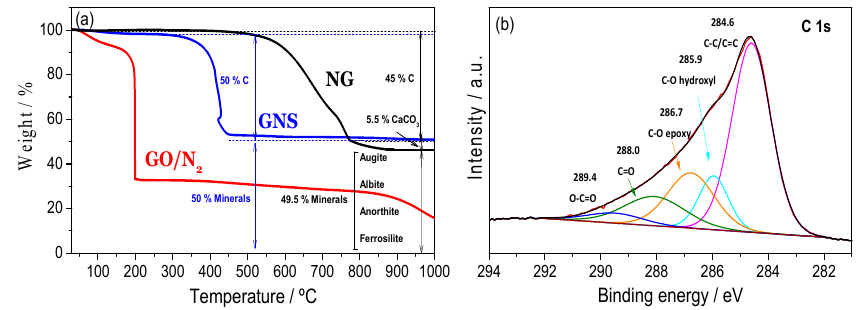
Figure 2. TG curves of NG, GO and GNS samples. The heating rate was 5 °C·min − 1 under oxygen, except for GO, which was carried out under N 2 ( a ); XPS spectra for the C 1 s photoemission peak of the GNS sample ( b ).